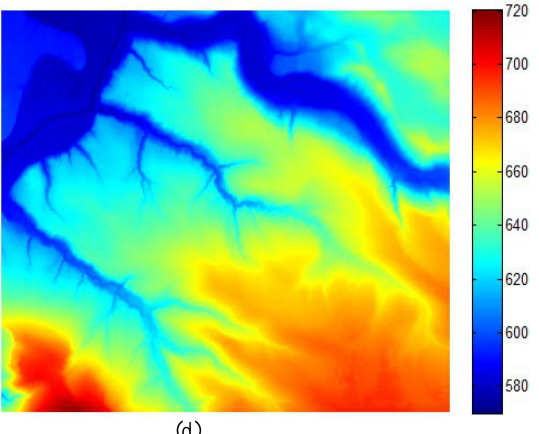
Figure 3. Experimental datasets: (a) panchromatic image; (b) DSM from Cartosat-1; (c) reference